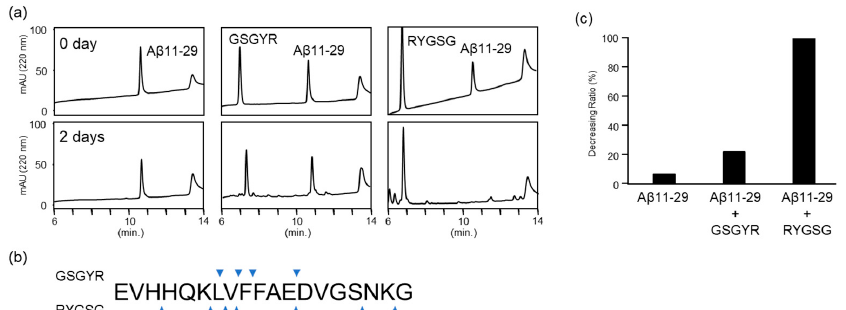
Figure 3. Cleavage reaction of A β 11-29 by GSGYR and RYGSG. ( a ) Time-dependent analysis of the reaction mixture of A β 11-29 alone (left), and with GSGYR (middle) and RYGSG (right) after 0 and 2 days. ( b ) The blue triangle indicates cleavage sites on A β 11-29. ( c ) Decreasing ratio of A β 11-29. The decreasing ratio was calculated by estimating the peak height of the chromatogram on day 0 and day 2.